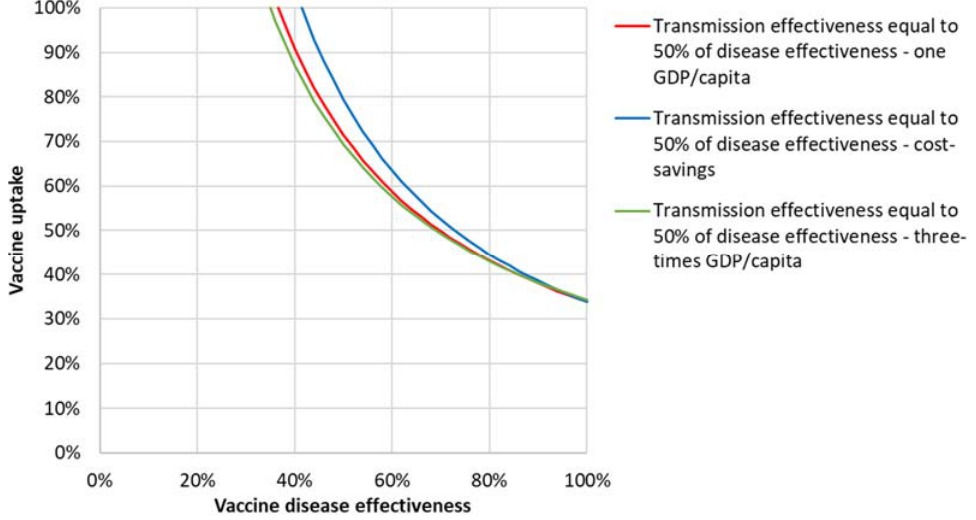
Figure 6. Iso-ICER lines from the societal perspective for transmission effectiveness equal to 50% disease effectiveness for one GDP/capita, three-times GDP/capita, and achieving cost